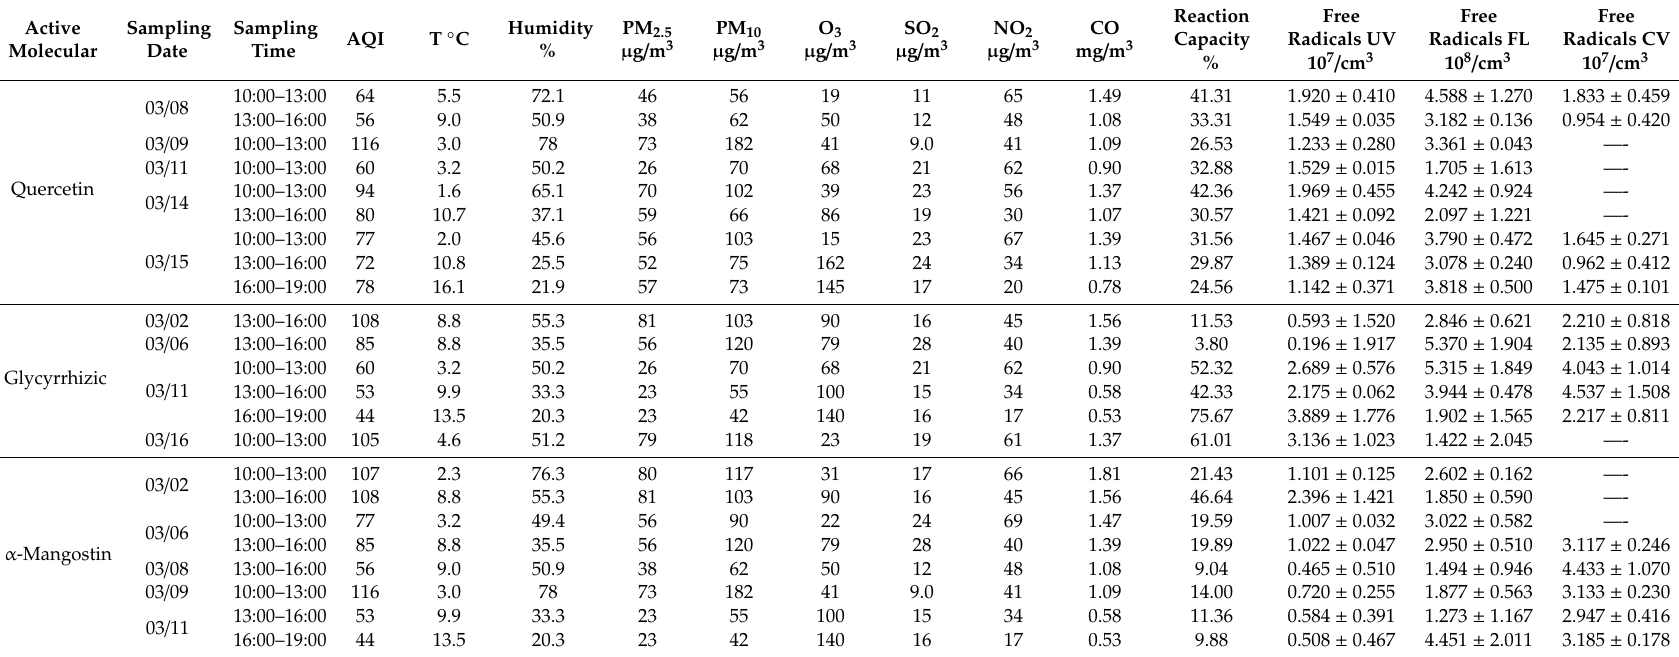
Table 8. The data of O 3 etc. at the same stage of sampling for the detection of free